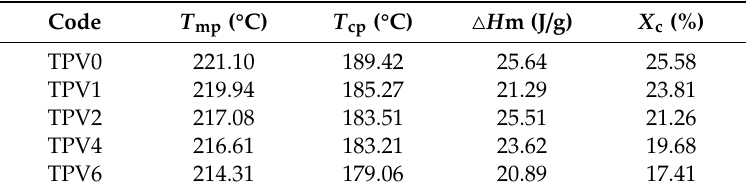
Figure 9. Wide-angle X-ray diffraction curves of TPV series.